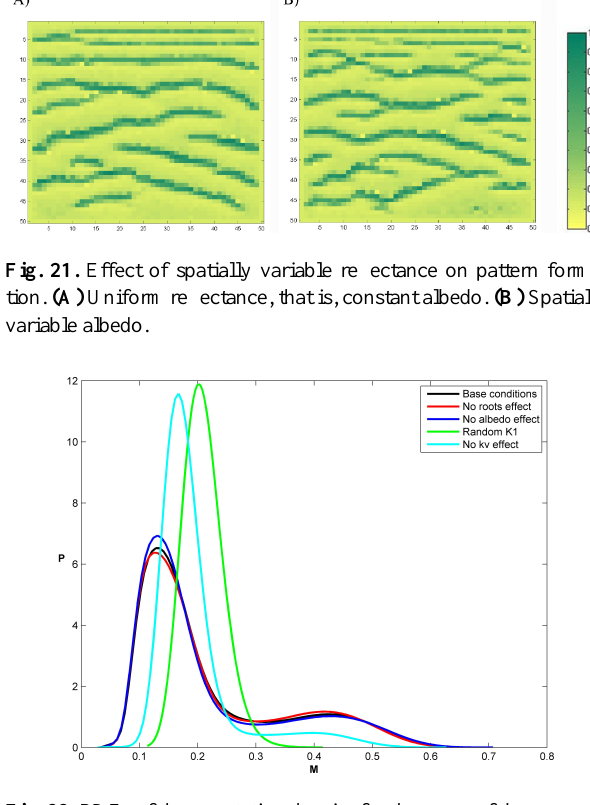
Fig. 22. PDFs of the vegetation density for the cases of: base condi- tions (black); no water redistribution due to roots (red); no spatially variable albedo (blue); hydraulic conductivity randomly distributed in space and independent from the vegetal density (green); no lateral facilitation and competition effects through transpiration efficiency